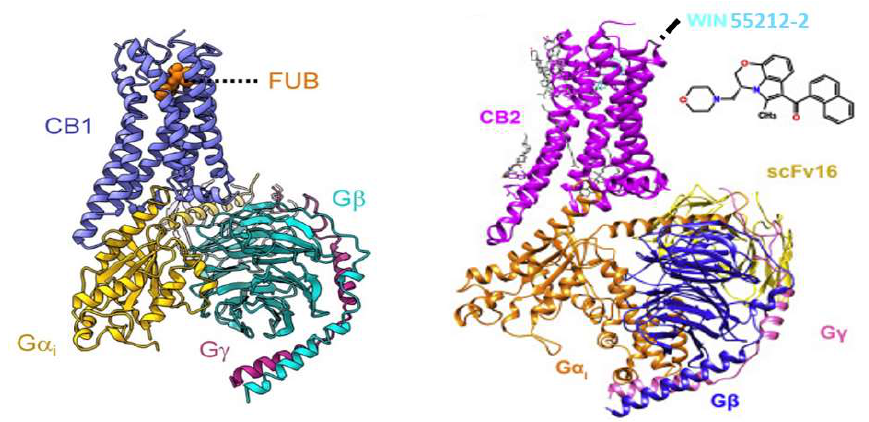
Figure 10. Cryo-electronmicrograph depicting structures of CB 1 cannabinoid receptor stimulated by FUBINACA (FUB) and engaging Giα1β1γ2 (left). Image reprinted with permission from Cell 176, Krishna Kumar, K. et al., Structure of a Signaling Cannabinoid Receptor 1 G Protein Complex ., copyright 2019, with permission from Elsevier [138]; and CB 2 cannabinoid receptor stimulated by WIN55212-2 and engaging Giα1β1γ2 (right). Image reprinted with permission from Cell 180, Xing, C. et al., Cryo-EM Structure of the Human Cannabinoid Receptor CB2-G i Signaling Complex. , copyright 2020, with permission from Elsevier [139].